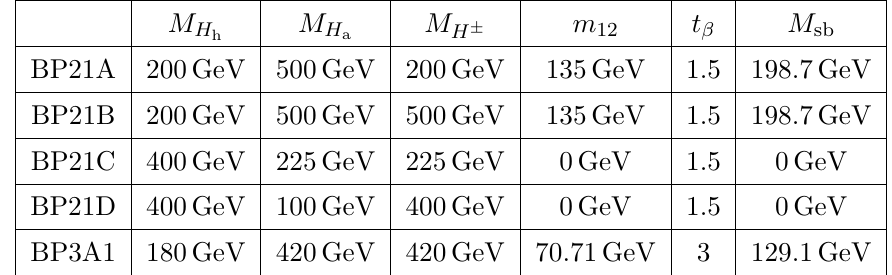
(cid:11)(cid:12) ! (cid:0) 1, c (cid:11)(cid:12) ! 0, taken from